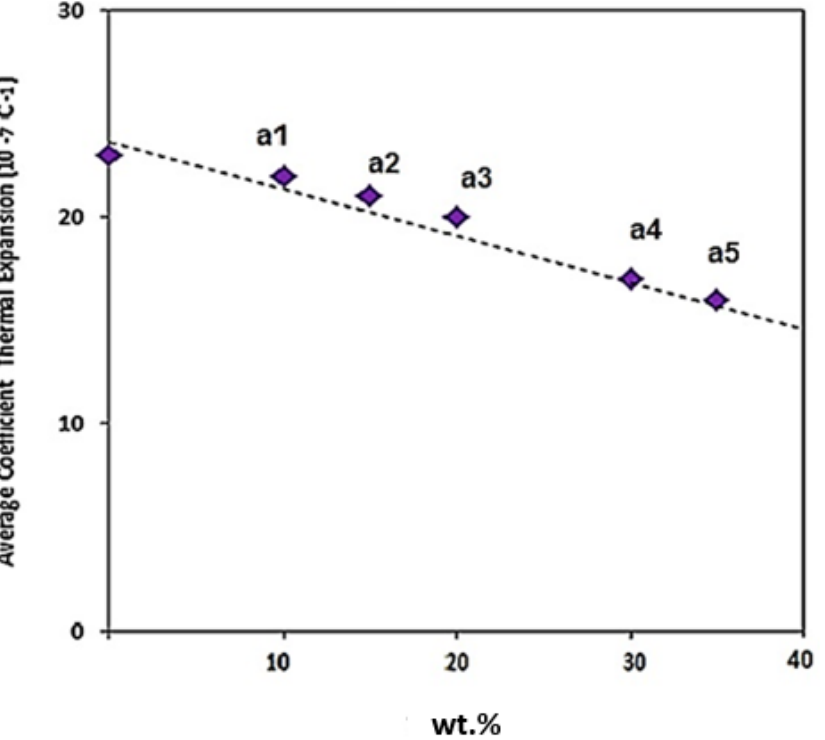
Figure 19. Linear expansion coefficients of the composites with different weight percentages of Fe 3 O 4 .